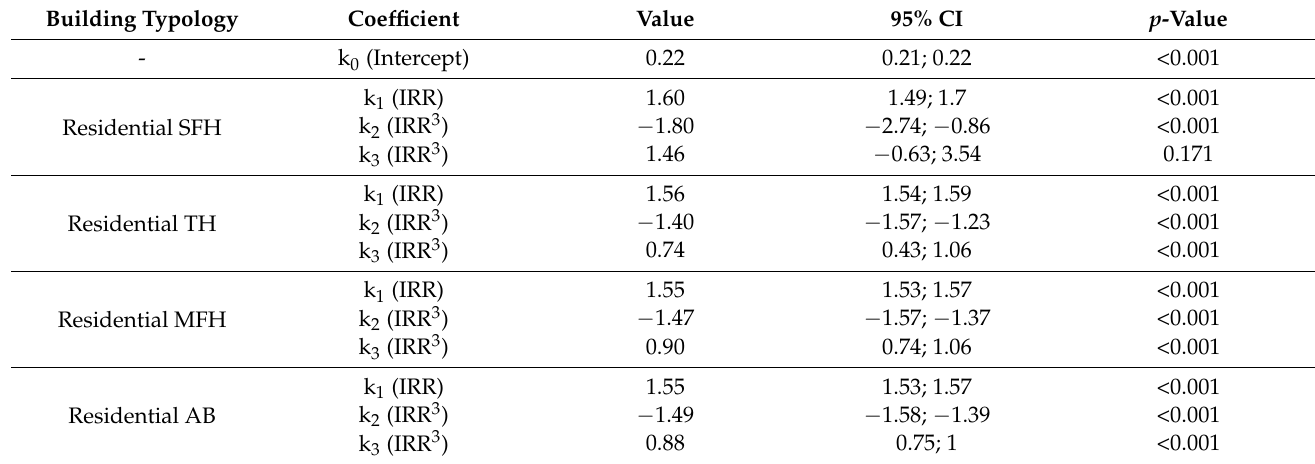
Table A4. QR coefficients to estimate PB for each building